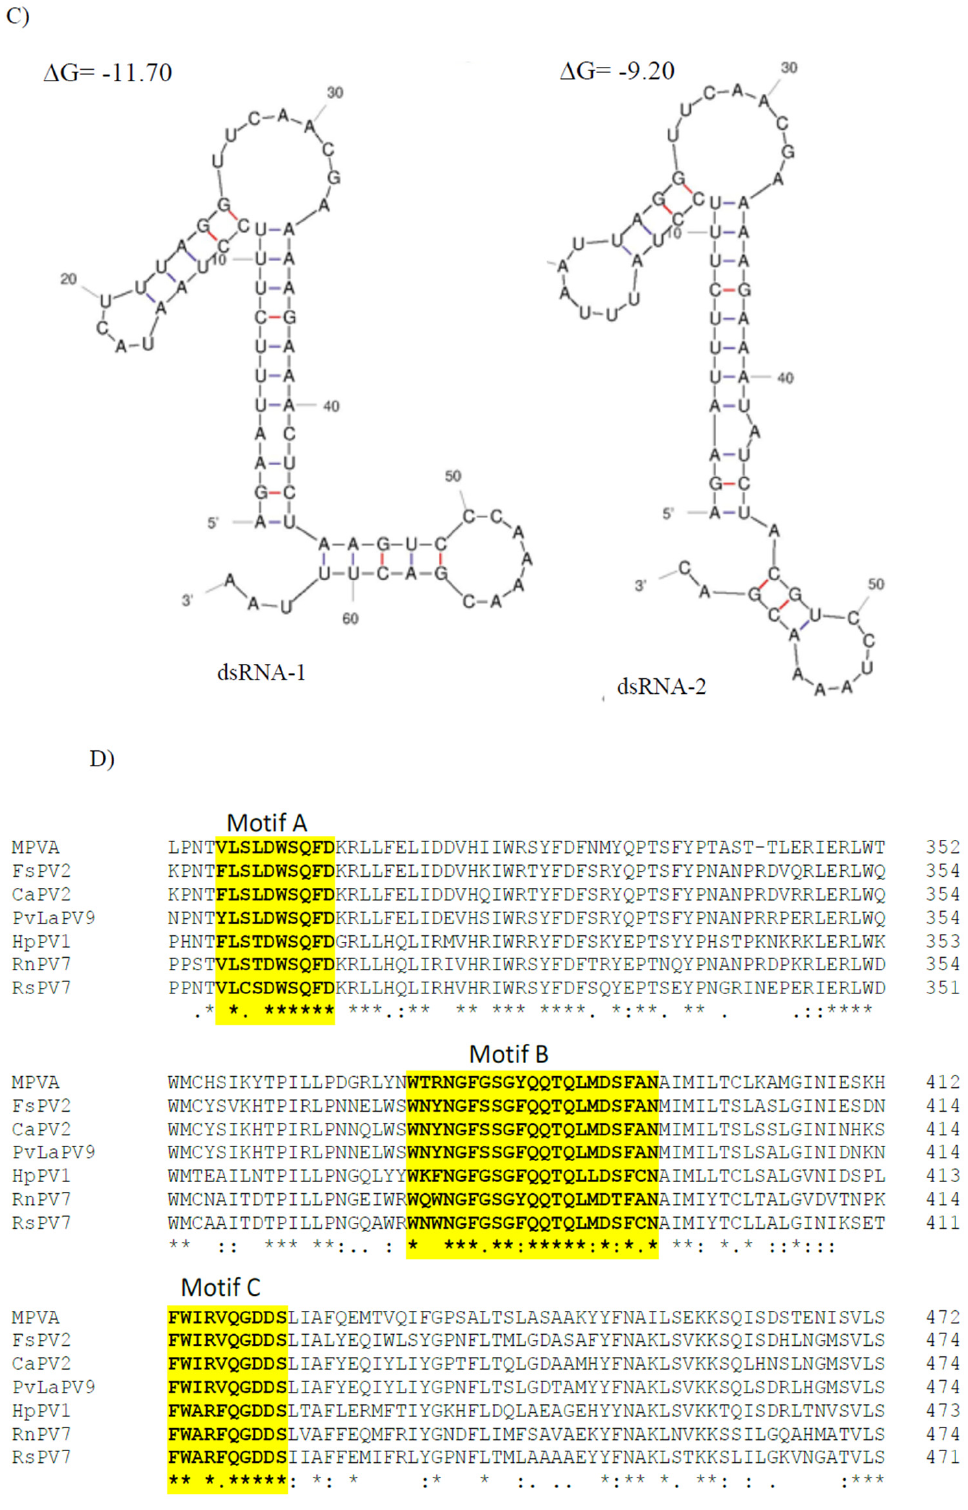
Figure 4. ( A ) Schematic representation of the CaPV2 genome organization. All the genome segments contain a single ORF (rectangular box) except dsRNA-3. dsRNA-1 encoded an RNA-dependent RNA polymerase (RdRp) and dsRNA-2 encoded a capsid protein (CP). The untranslated regions (UTRs) at both termini of dsRNA segments are also shown. ( B ) Sequence alignment of the respective 5 ′ UTRs between dsRNA-1 and dsRNA-2 of CaPV2. ( C ) Predicted secondary structure of the 5 ′ UTR sequences of CaPV2 dsRNA-1 (left) and dsRNA-2 (right). ( D ) Multiple sequence alignment analysis of RdRp from different members of the genus Alphapartitivirus revealed that CaPV2 RdRp contains all three conserved motifs (motifs A–C) found in the catalytic palm subdomain and these motifs are well conserved among dsRNA viruses. The conserved motifs are indicated by the colored boxes.